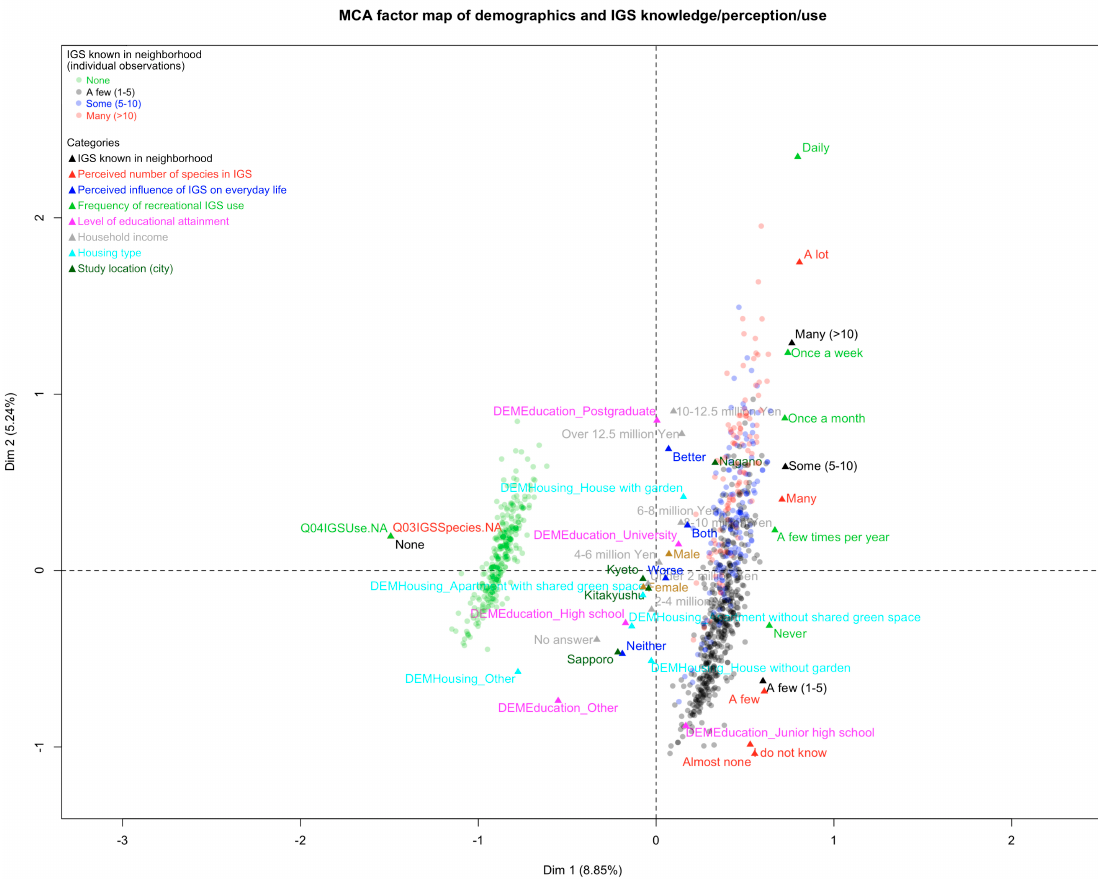
Figure 10. Multiple correspondence analysis of key IGS and demographic variables.